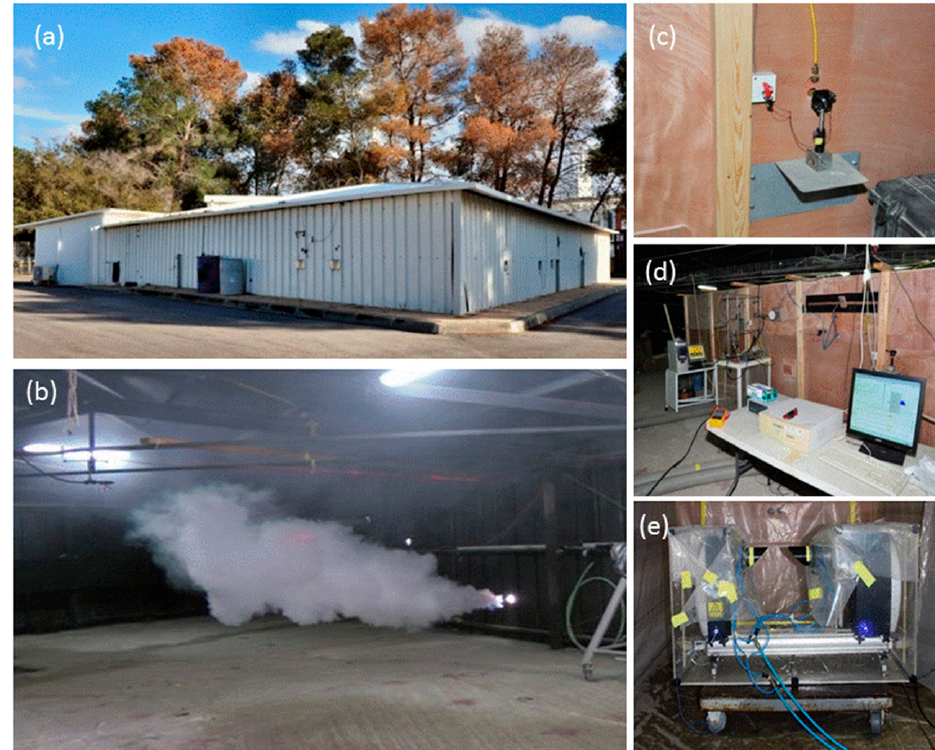
Figure 6. ( a ) Israel Institute for Biological Research (IIBR) aerosol chamber. ( b ) Initial filling of an artificial cloud into the chamber. ( c ) External view of one of the diodes that served for transmission measurements. ( d ) External chamber wall, showing remote control instrumentation. ( e ) Spraytec instrument for measuring the droplet size distribution in real-time. The JAI camera was operated with and without a polarizer. For the unpolarized tests, a 1.5 ms integration time was set. For the polarized test, 7 ms was chosen, in order to compensate for the reduced illumination power and the receiver polarizer. The camera field of view as well as the projector illumination beam shape were chosen to match the physical size of the fog chamber so adjacent walls would not be illuminated. Figure 7 shows the analyzed return at a single detector line for two different visibility ranges. The setup included a narrow white board located 6.1 m from the sensor (see Figure 2). The return signal of the un-polarized test was multiplied by integration times ratio of the two tests. It can be seen that the backscatter signal of the polarized setup is significantly reduced. The larger backscatter on the right side of this cross-section resulted from the geometrical setup, in which the projector was located to the right of the sensor. The backscatter level at 7 m visibility was only slightly increased with respect to the 20 m visibility. However, the signal from the target at 7 m visibility was almost invisible. The forward and backward attenuation for a path length which is very close to visibility range reduced the received signal to below noise level. Figure 7 shows the analyzed return from the detector in two different visibility ranges; for a setup where a white target is located 6 m from the sensor, see Figure